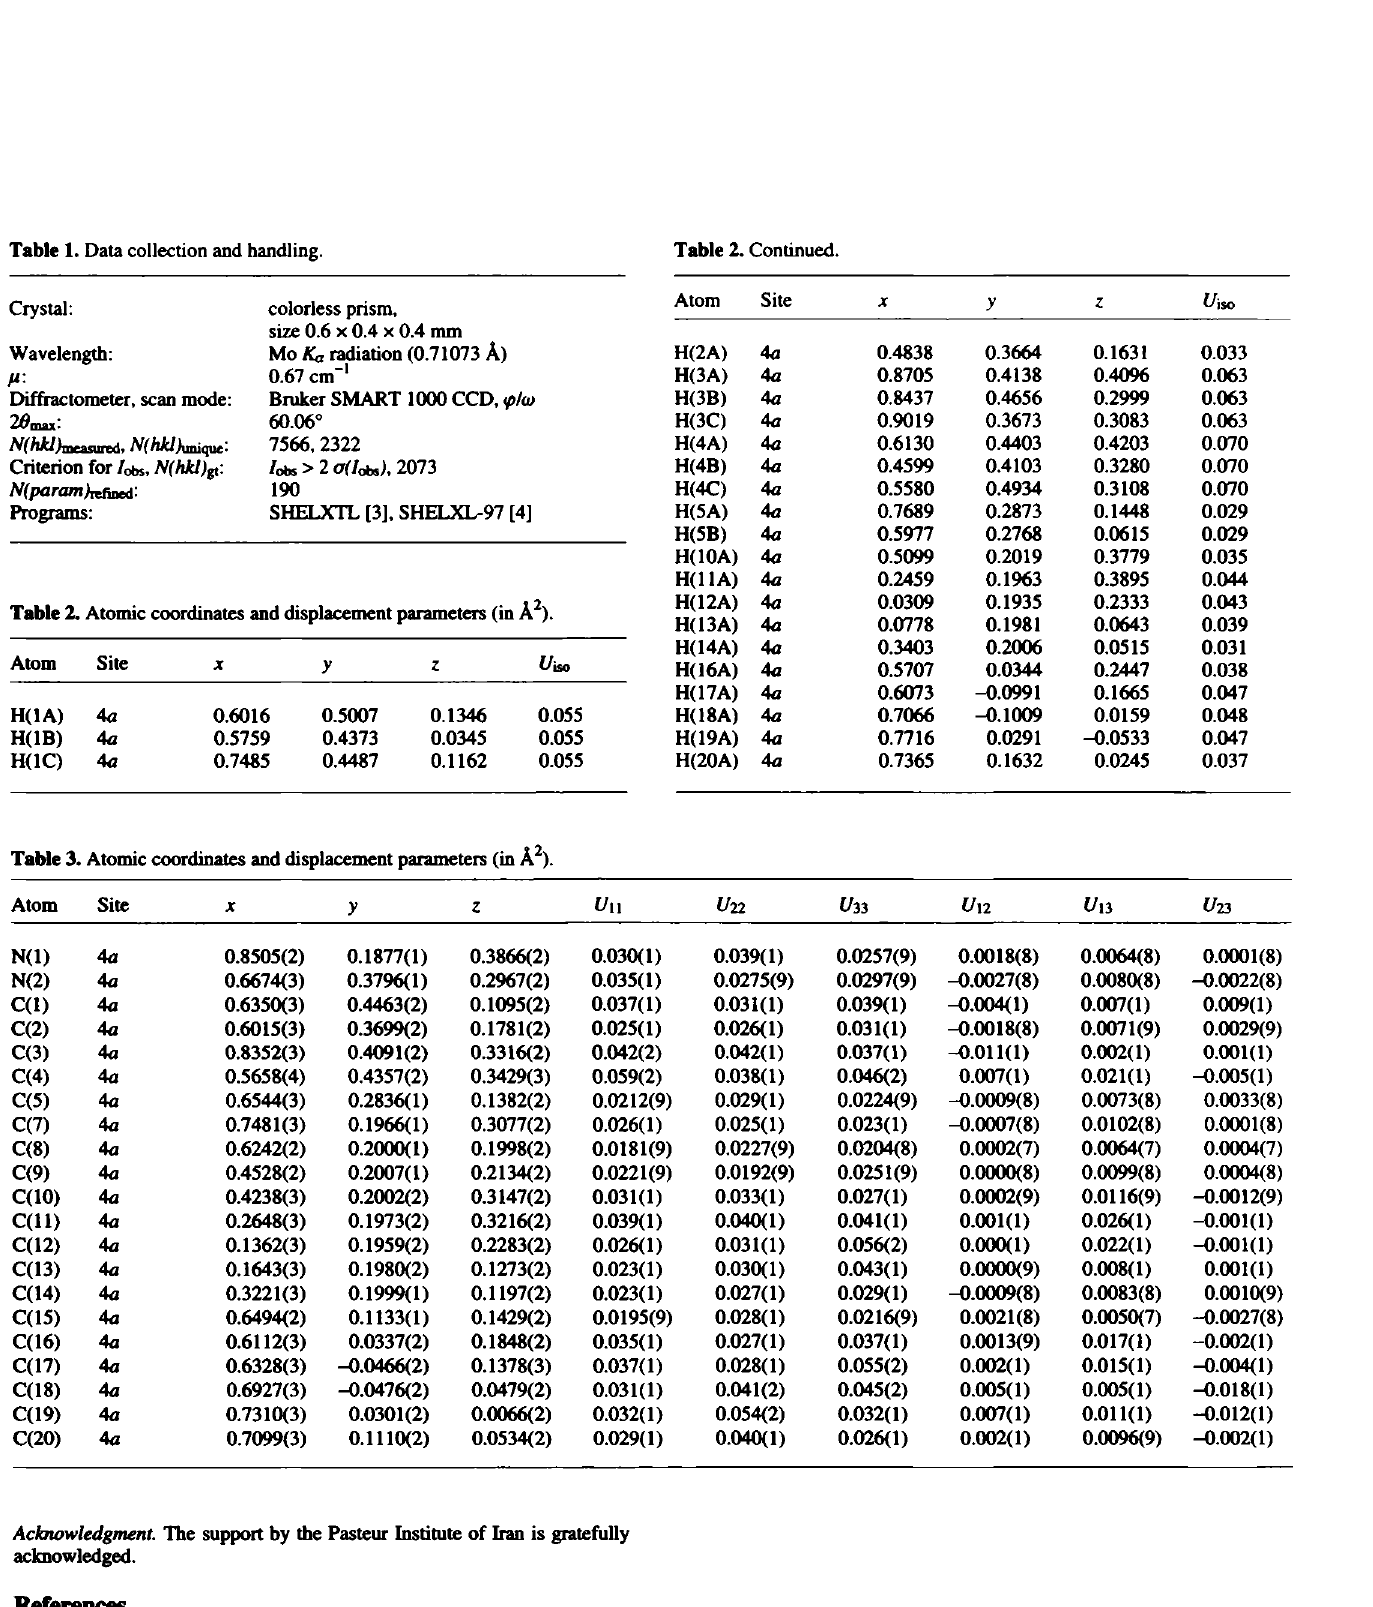
Table 1. Data collection and handling.